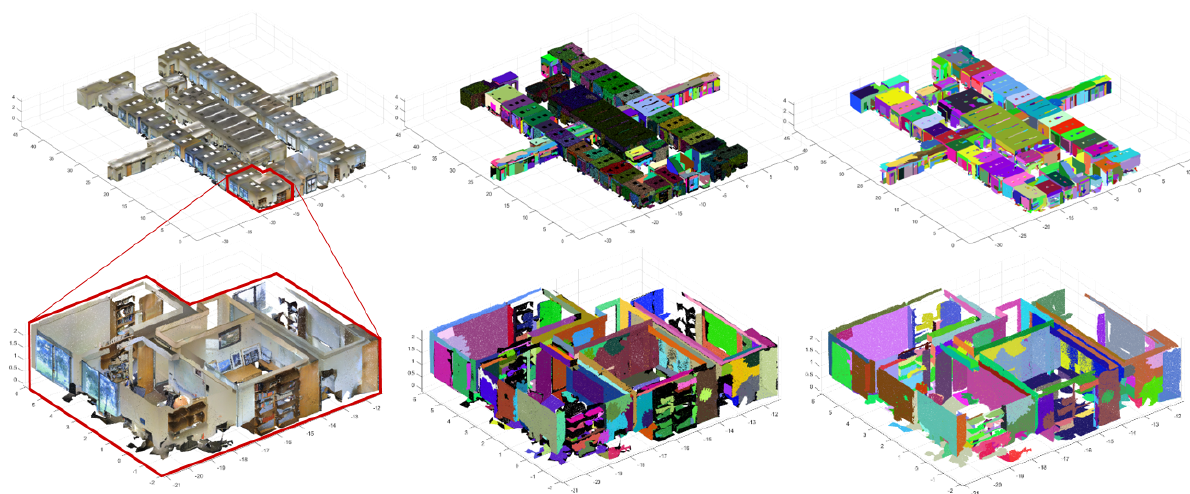
Figure 4 . Overview experiments Stanford 2D-3D-Semantics Dataset (2D-3D-S): The top and bottom row respectively depict segmen- tation and classification results for Area1 and a subset of Area1 for clarification. From left to right can be viewed: Initial point cloud (left), oversegmented clusters with non-valid clusters in black (mid) and the final grouped clusters (right). Table 1 . Segmentation results of the Stanford 2D-3D-Semantics Table 2 . Clustering results of the Stanford